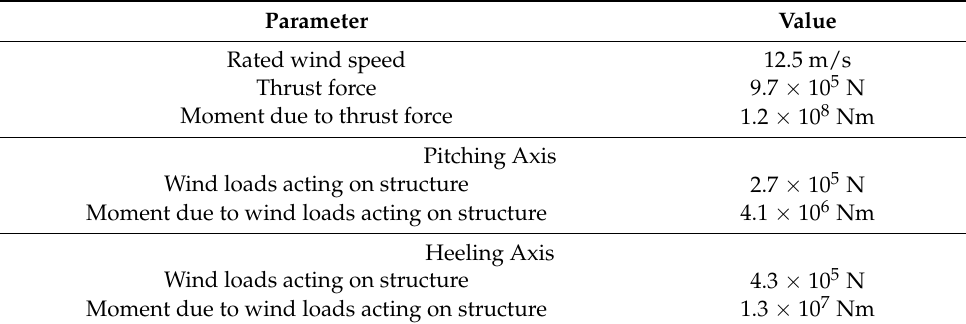
Table 8. Wind loads acting on the